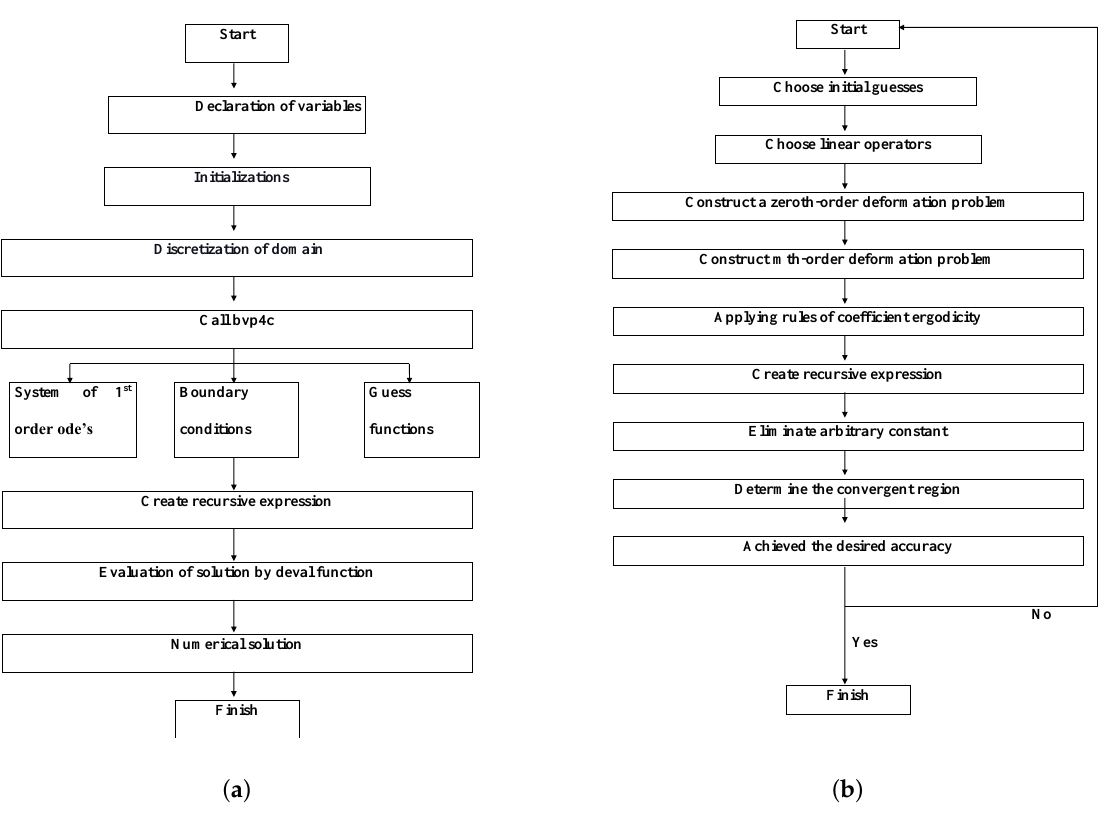
Figure 2. The flow chart of bvp4c ( a ) and HAM ( b